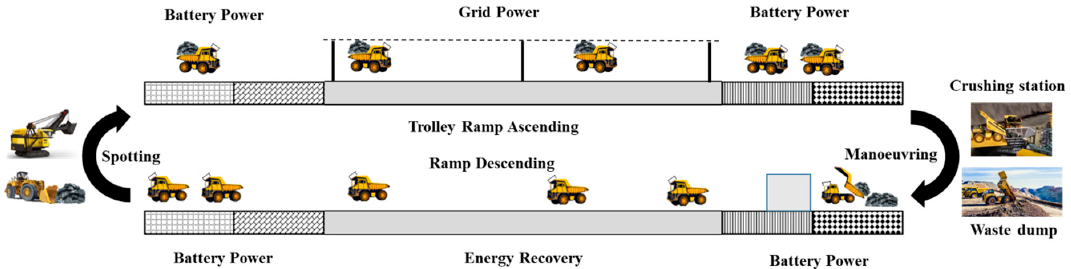
Figure 16. A schematic of a typical BT systems power source.